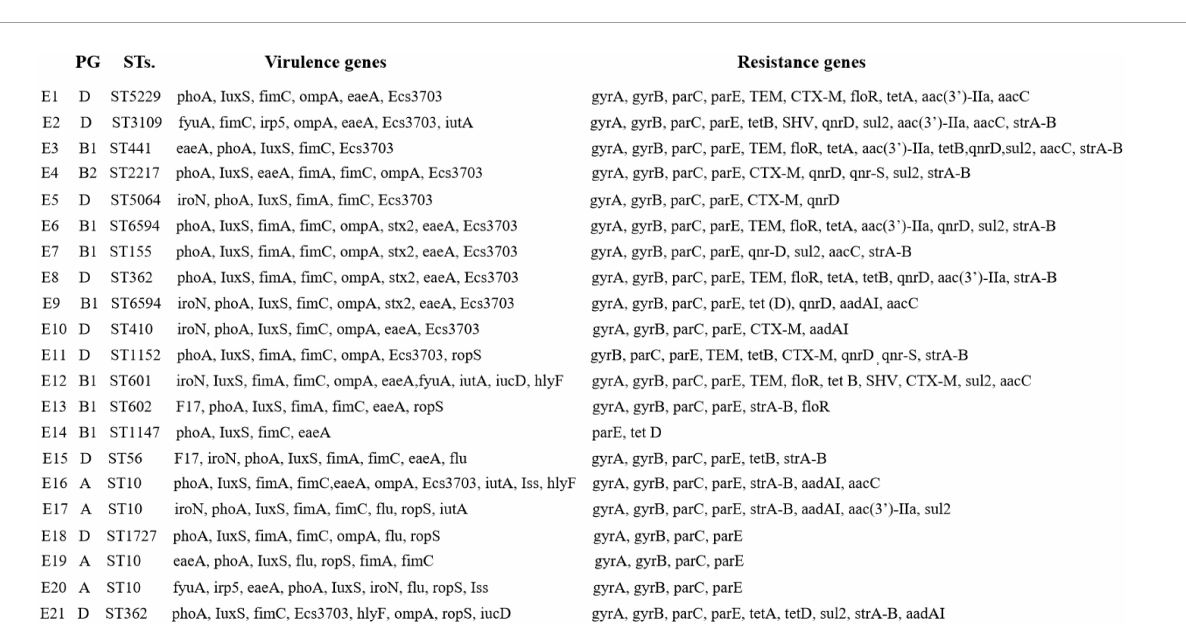
FIGURE5 Comparison of virulence and resistance genes in diarrheagenic calves source Escherichia coli .